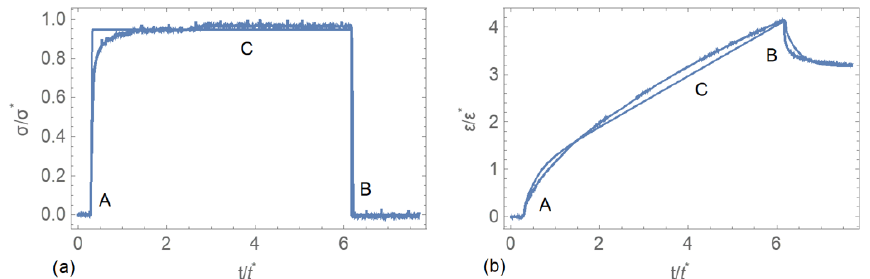
Figure B7. (a) Dimensionless stress and (b) normalized strains versus dimensionless time. Thick and thin lines correspond to measured and simulated quantities, respectively. LU test with a core of spray sea ice.